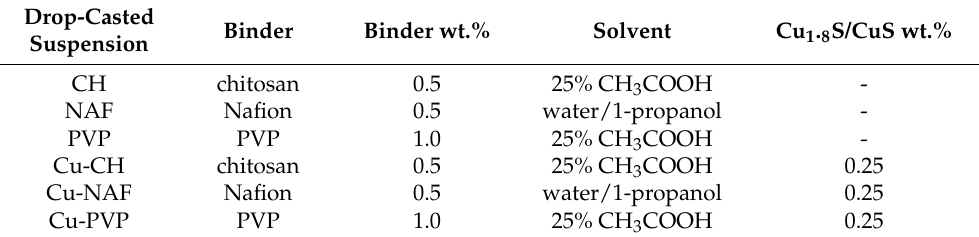
Table 1. Composition of drop-casted